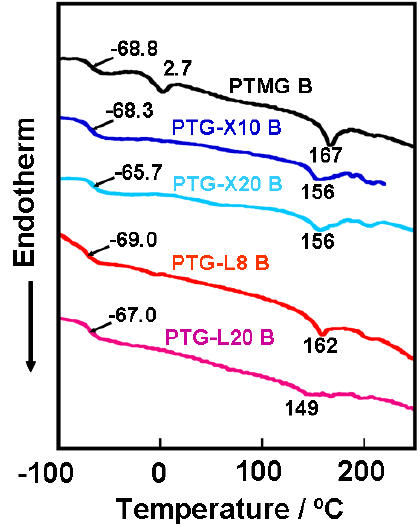
Figure 1. DSC curves for the PTMG, PTG-X and PTG-L based